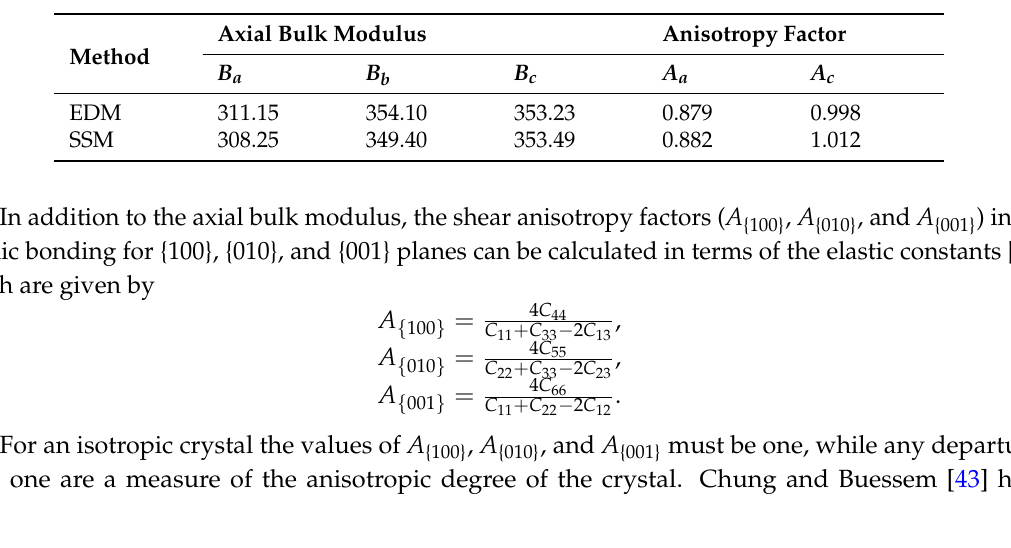
Table 5. The bulk modulus along the axes a , b , c ( B a , B b , B c in GPa) and anisotropic factors ( A a , A c ) of B19